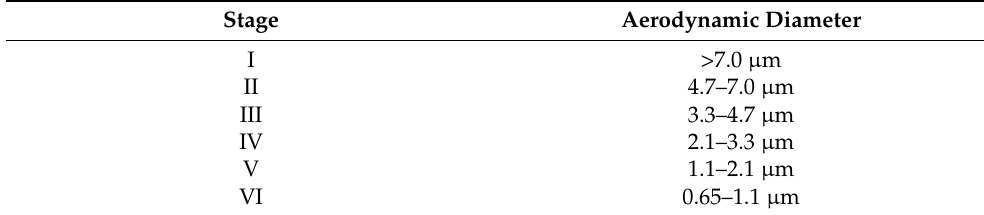
Table 1. Range of bioaerosol particles